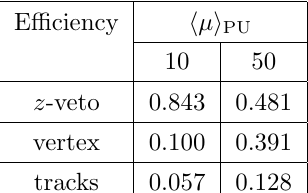
Table 1 . The signal z -vertex veto e(cid:14)ciency for the mass combination M ~ and two values of (cid:22) . The ‘vertex’ (‘tracks’) row shows the fractions of events where at least one vertex (where no vertex but at least one track) is found in the region (cid:6) 1 mm from the primary